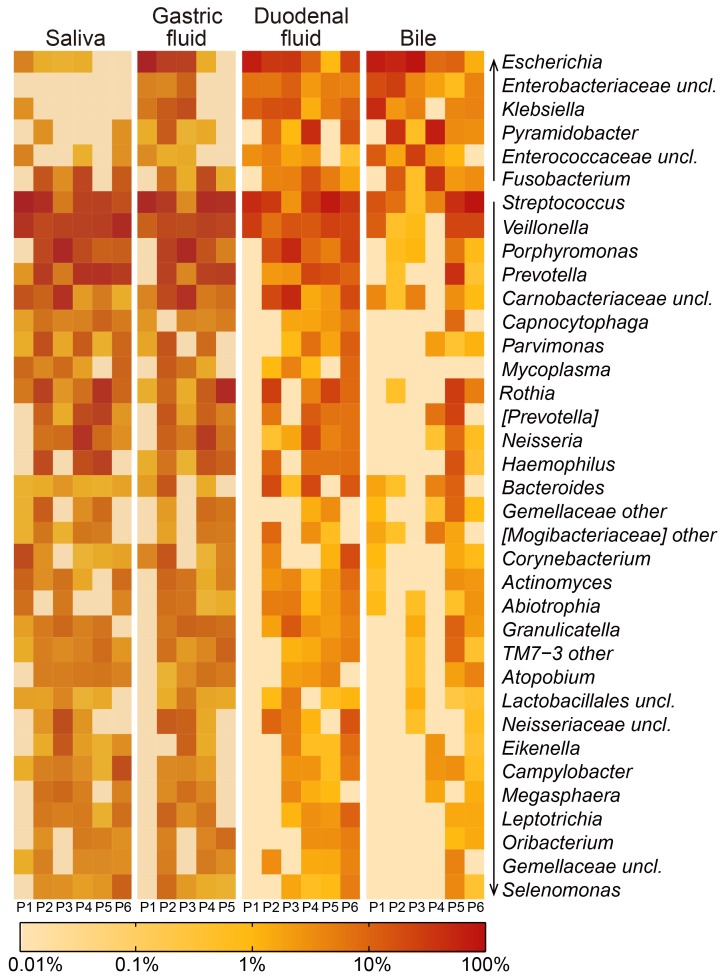
Distribution of genera that were highly prevalent across the four body sites.Only genera with ≥0.01% abundance in at least 12 samples are presented. OTUs that could not be assigned at the genus level were labelled as “unclassified” (uncl.). Genera that were poorly defined in Greengenes database were labelled as “other”. [Prevotella] and [Mogibacteriaceae] are provisional taxonomical assignments of operational taxonomic units by Greengenes. The upward and downward arrows indicated genera whose abundance was increased and decreased in bile samples, relative to the other regions, respectively.